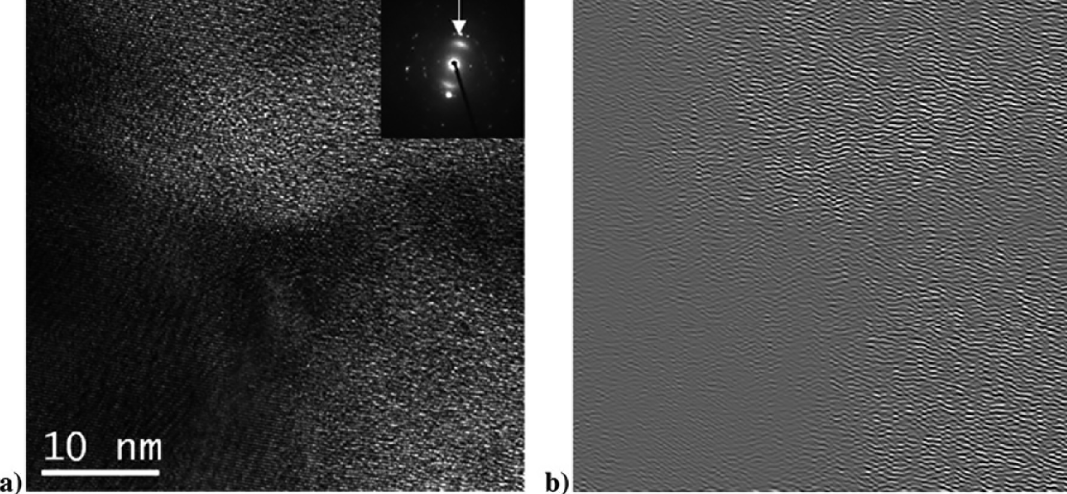
Figure 5. a) High resolution EFTEM micrograph of graphite next to magnetite grains. SAED pattern inset (from the area of the small white square in Fig. 4a); b) Inverse fast Fourier transform (FFT) reconstructed from the graphite spots, showing that planes are crumpled. Same scale for both